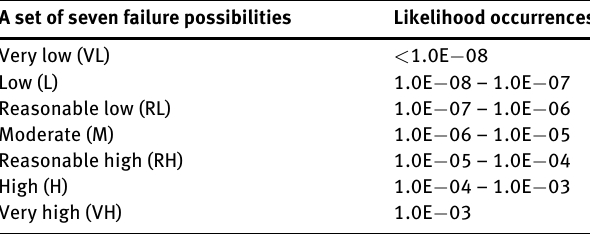
Table 3: The Failure Possibilities/Linguistic terms and Their Likelihood Values [36, 37].